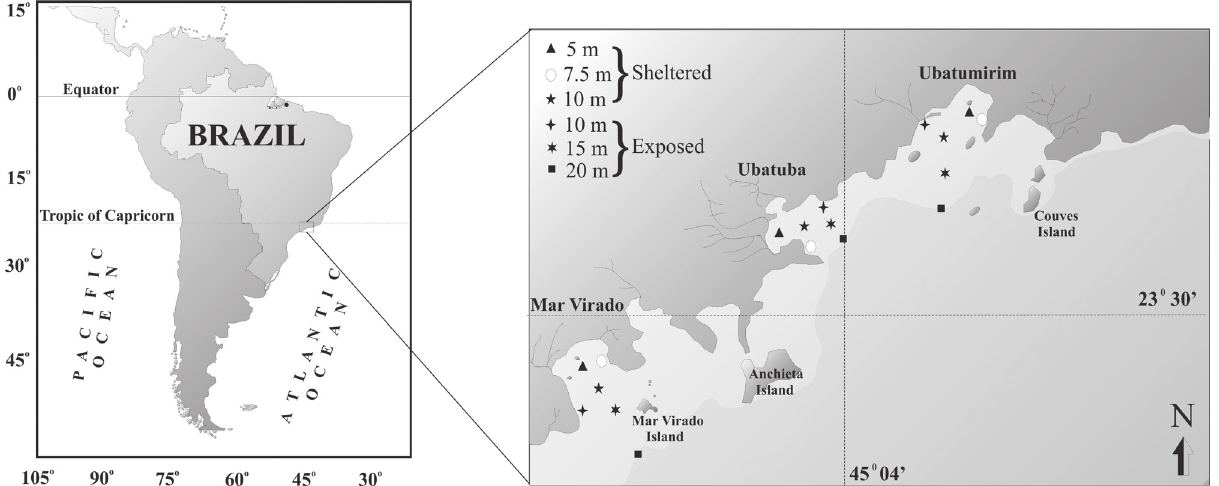
Figure 1. Map of the Ubatuba region, northern coast of the São Paulo state, Brazil, showing bays, areas (exposed and sheltered) and sampling